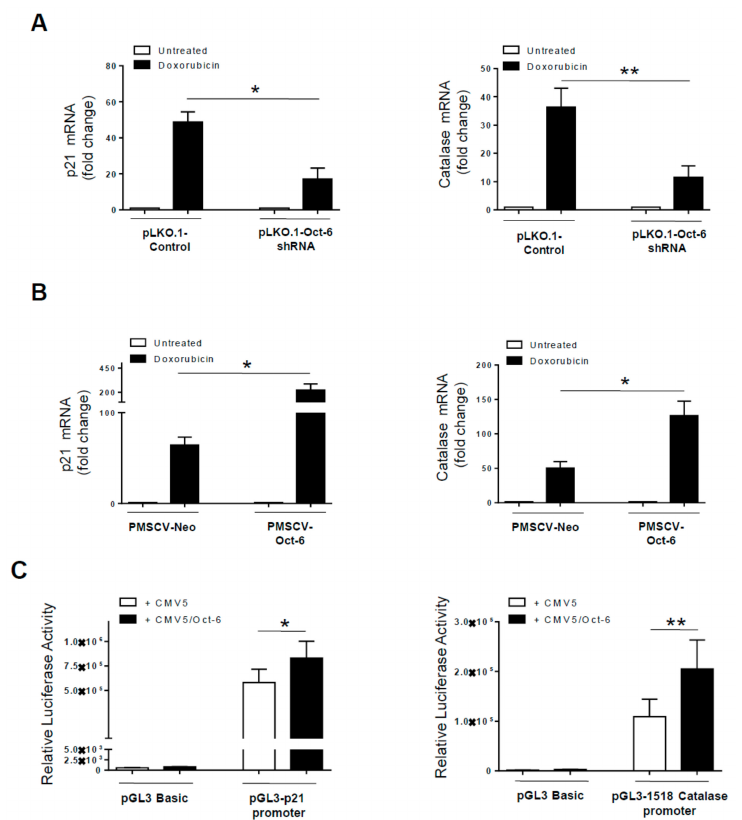
Figure 5. The p21 and catalase as Oct-6 target genes. The total mRNA was obtained from Oct-6 silenced or overexpressing H460 cells unstimulated ( − ) or treated with Dox for 24 h, and analyzed for p21 or catalase mRNA expression by real-time PCR ( A , B